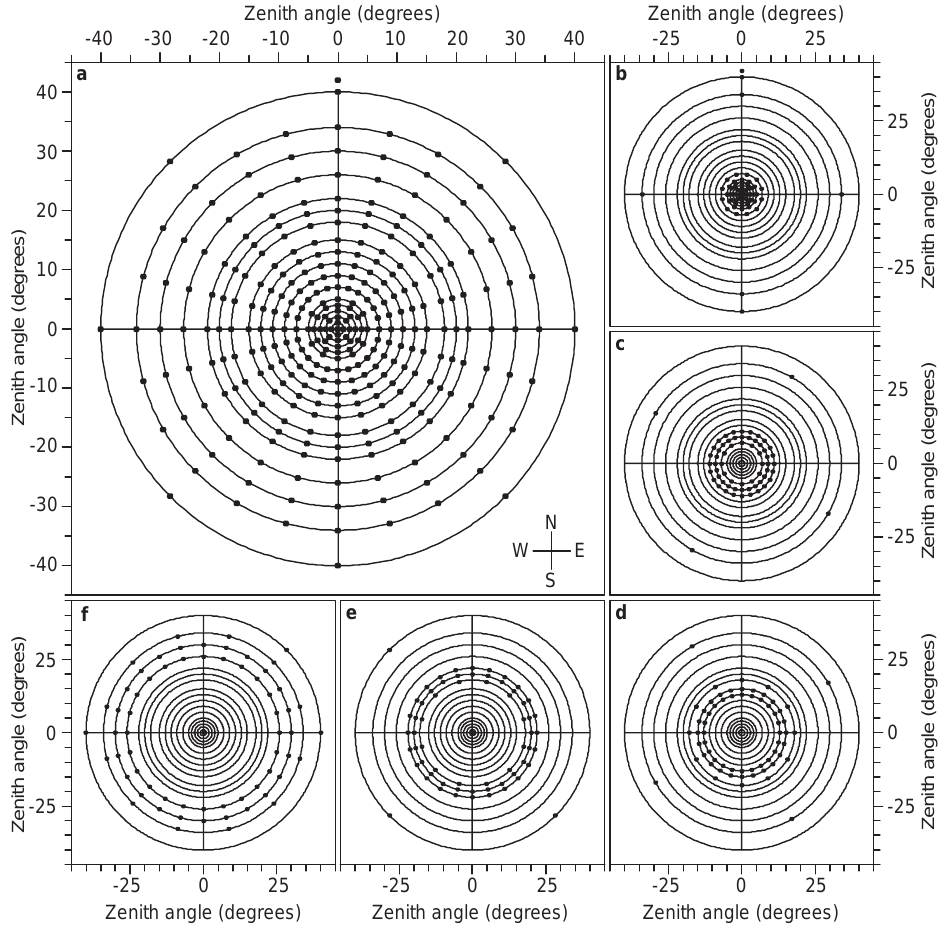
Fig. 1. Layout of the 320 radar beams, viewed from above; a the complete pattern, b–f five sub- groups of 64 beams each, used to build up the 320-beam